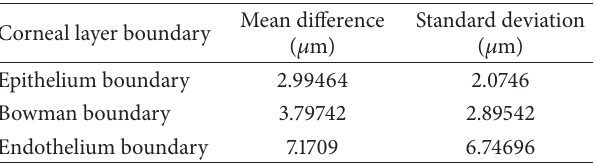
Table 1: Mean and standard deviation of unsigned error in corneal layer boundary segmentation between automatic and manual seg- mentation using GMM.